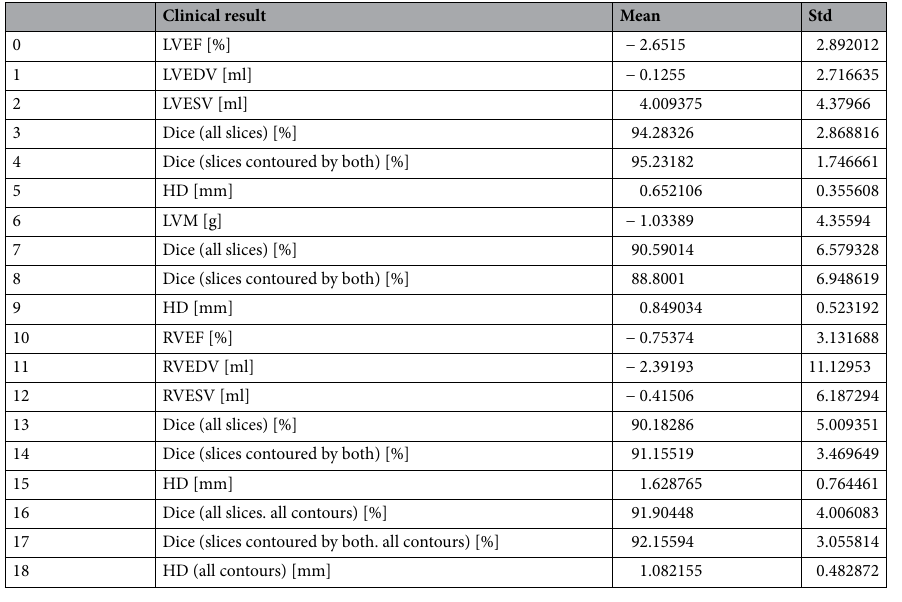
Table 1. Title: Reader comparison of clinical results and segmentation metric values. Caption: Clinical result differences between readers are presented in their averages and standard deviations (in blue). They are joined with metric value averages concerning the clinical results above them (in grey). For example: the Dice values below LVEF, LVEDV, LVESV concern the LV cavity. The table presents two Dice values, one for all slices, another restricted to slices segmented by both readers. LV: Left ventricle, LVEF: Left ventricular ejection fraction, Legend: LVEDV: Left ventricular end-diastolic volume, LVESV: Left ventricular end-systolic volume, HD: Hausdorff metric, LVM: Left ventricular myocardial mass, RVEF: Right ventricular ejection fraction, RVEDV: Right ventricular end-diastolic volume, RVESV: Right ventricular end-systolic volume, Std.: Standard deviation.